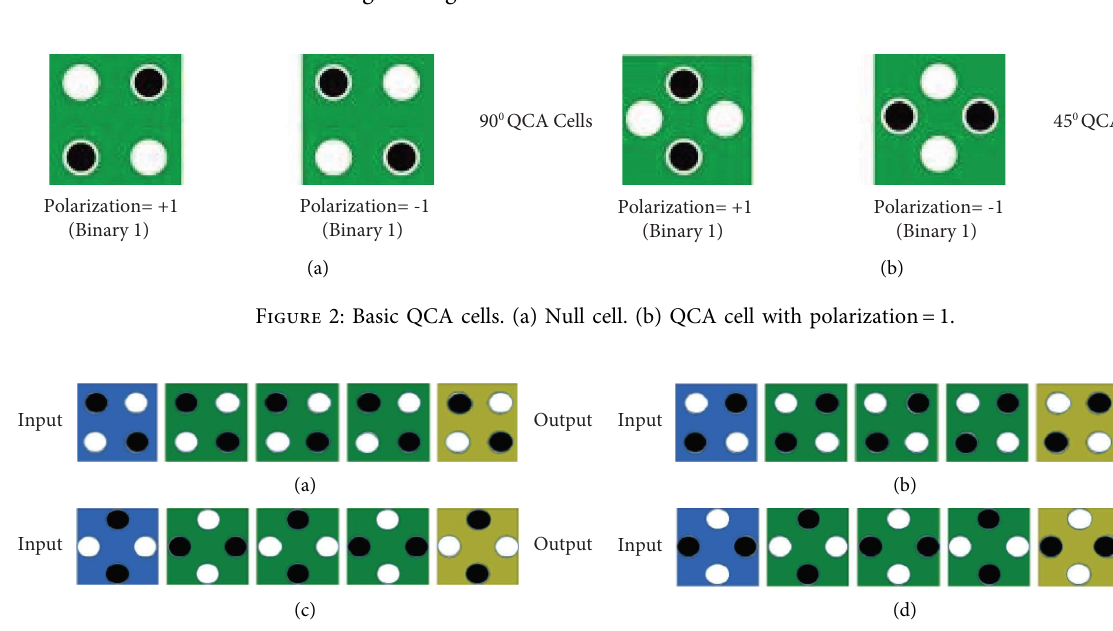
Figure 3: QCA wire. (a) Binary 1 logic transmission in 90 ° wire. (b) Binary 0 logic transmission in 90 ° wire. (c) Binary 1 logic transmission in 45 ° wire. (d) Binary 0 logic transmission in 45 ° wire.